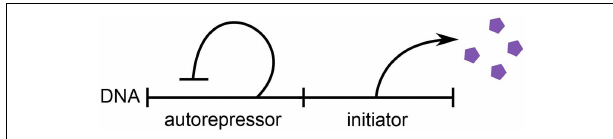
FIGURE 1 | Schematic of the autorepressor model of initiator expression. An autorepressor is expressed such that its concentration remains constant and independent of the growth rate of the cell. The initiator is expressed in proportion to the autorepressor, but is localized at the origins of replication. Adapted from Sompayrac and Maaloe